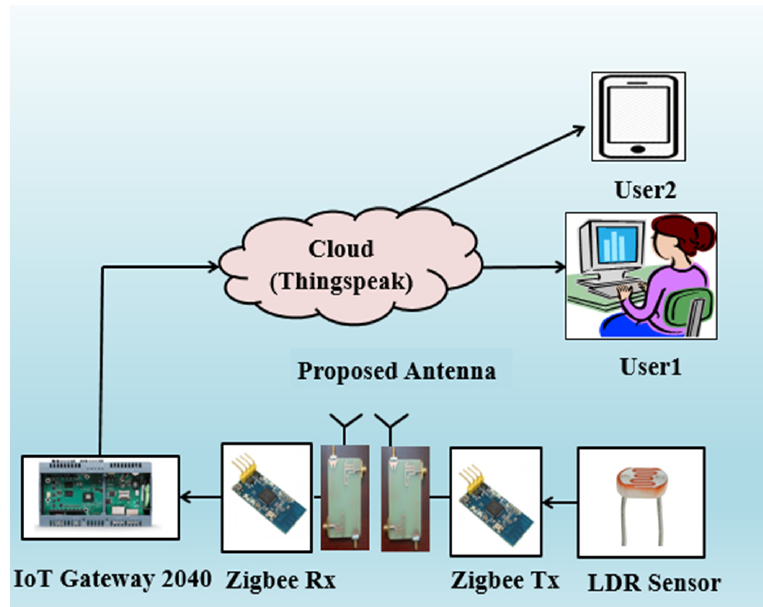
Figure 16. System architecture of the proposed smart home application.